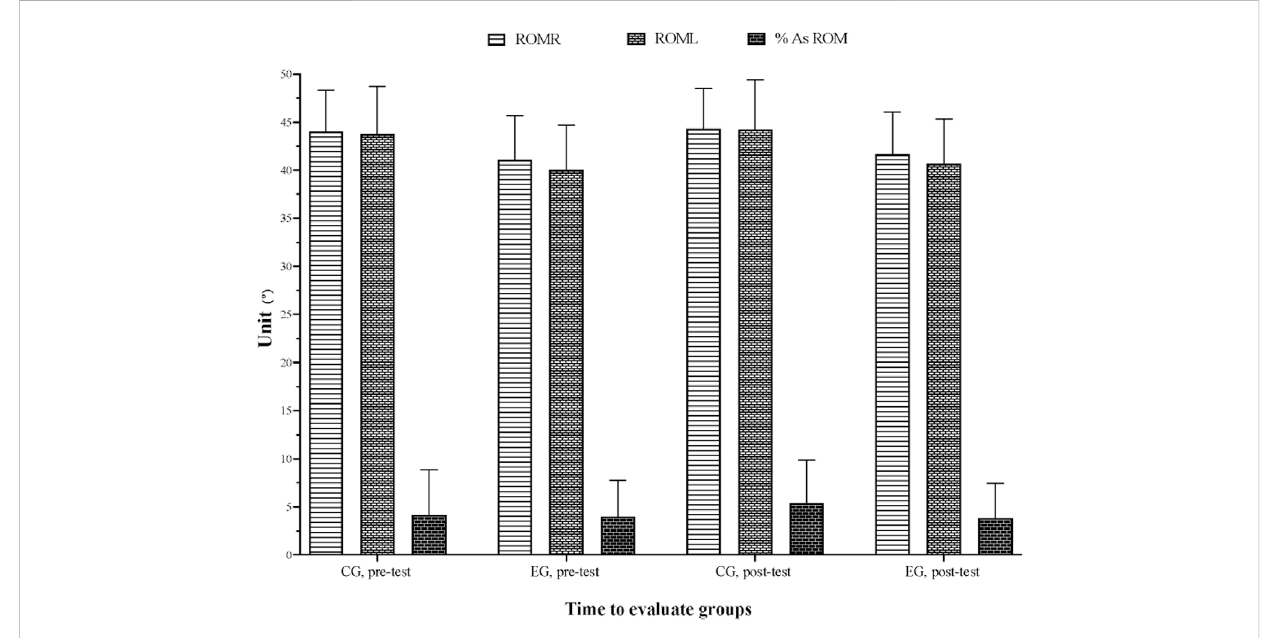
FIGURE 2 Variation in ROM variables for control and experimental